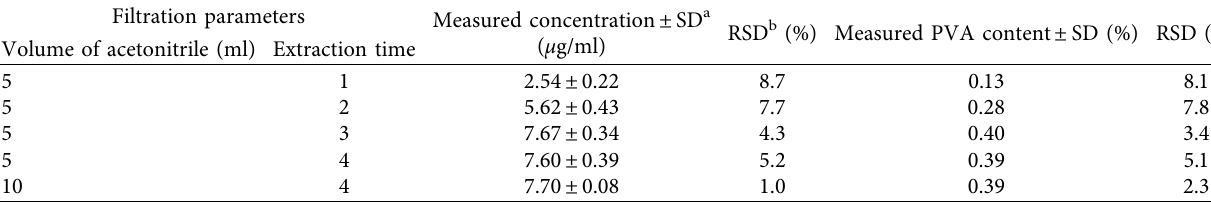
Table 1: The results for investigation of extraction. Filtration